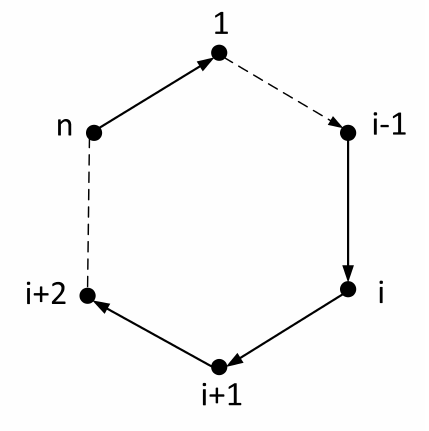
Figure 3. Cyclic pursuit